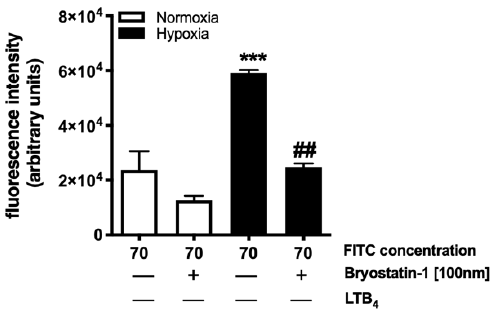
Figure 5. Bryostatin-1 acts by altering neutrophil – endothelial cell crosstalk pathways, rather than directly affecting the vascular endothelium. Confluent human umbilical vein endothelial cell (HUVEC) monolayers were treated with Bryostatin-1 (100 nM) or vehicle (1 X PBS), subjected to hypoxia or normoxia, followed by the addition of calcein-AM labeled neutrophils and leukotriene B 4 (LTB 4 , 10 − 6 M). After three hours, neutrophils were removed, FITC-dextran (70 kDa) was added, and permeability was measured. Bryostatin-1 significantly reduced permeability for FITC-dextran. The migration index was calculated by dividing the number of calcein-AM labeled neutrophils that migrated to LTB 4 by the number of cells that migrated to the vehicle. All results are representative of at least three independent experiments (n = 7). Graphs present mean ± SEM, data were analyzed with ANOVA with Bonferroni post-tests, and significance is indicated by the following symbols: *** p < 0.0001 versus the respective normoxia group; ## p < 0.001 versus vehicle control.